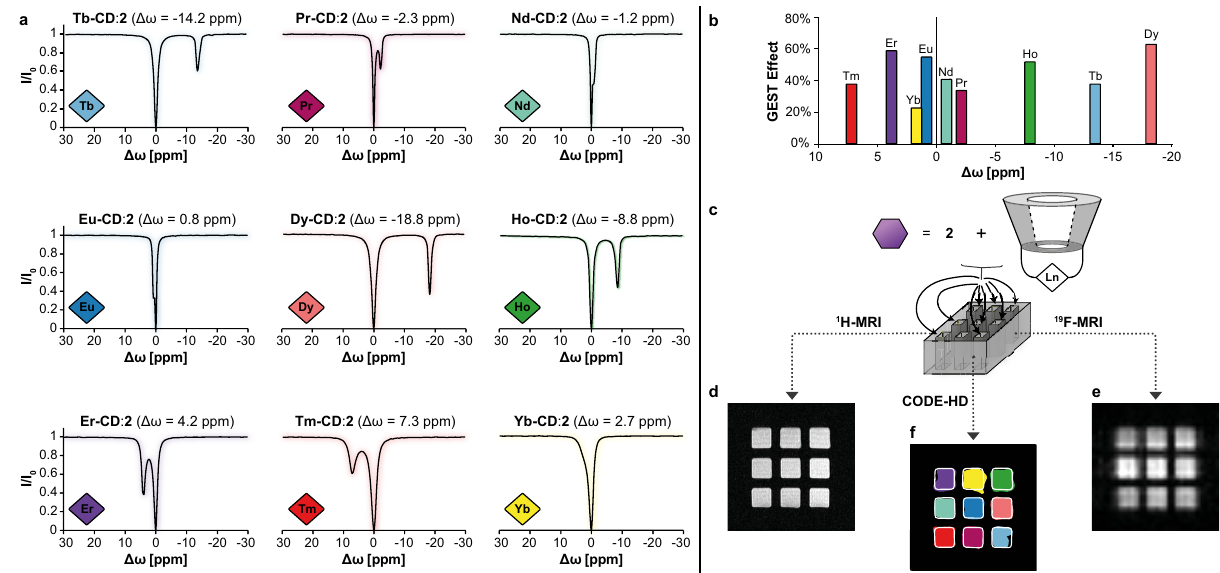
Fig. 3 COlor Display by Exploiting Host – guest Dynamics (CODE-HD) construction and pseudo-color assignment. a z-Spectra of aqueous solutions containing lanthanide-cyclodextrin ( Ln-CD ) hosts (represented as color diamonds) and guest 2 . b Color-coded guest exchange saturation transfer (GEST) effect plots of the studied library shown in a . c Schematic illustration of the obtained CODE-HD setup of a 3 × 3 multiwell plate loaded with nine different Ln-CD hosts (one host/well) and guest 2 . Shown are proton magnetic resonance imaging ( 1 H-MRI) ( d ), 19 Fluorine-MRI ( 19 F-MRI) ( e ), and CODE-HD map ( f ), where each color represents the chemical shift offset ( Δ ω ) of each Ln-CD : 2 paramagnetic GEST effect (paraGEST, the color-code shown in b and assigned in Supplementary Table